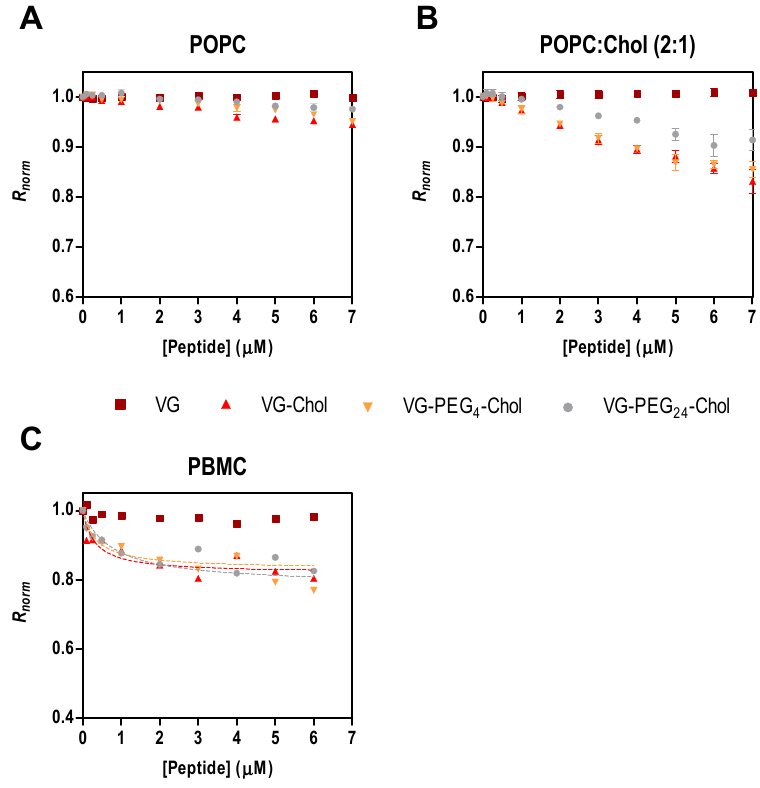
Figure 2. Fusion inhibitory peptides’ interaction with di-8-ANEPPS labeled liposomes and cells. Binding profiles of VG peptides to LUVs of POPC ( A ) or POPC:Chol 2:1 ( B ), and to human PBMC ( C ), obtained by plotting the di-8-ANEPPS excitation ratio R (I 455 /I 525 , normalized to the initial value), as a function of peptide concentration.